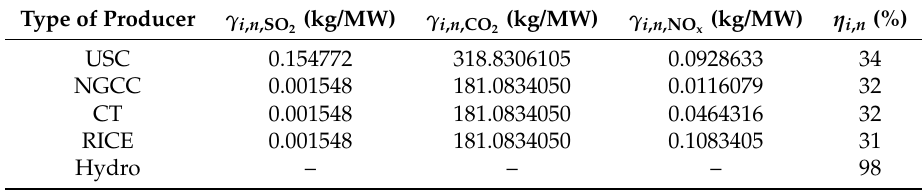
Table 4. Coefficients of the indicators for the different producers